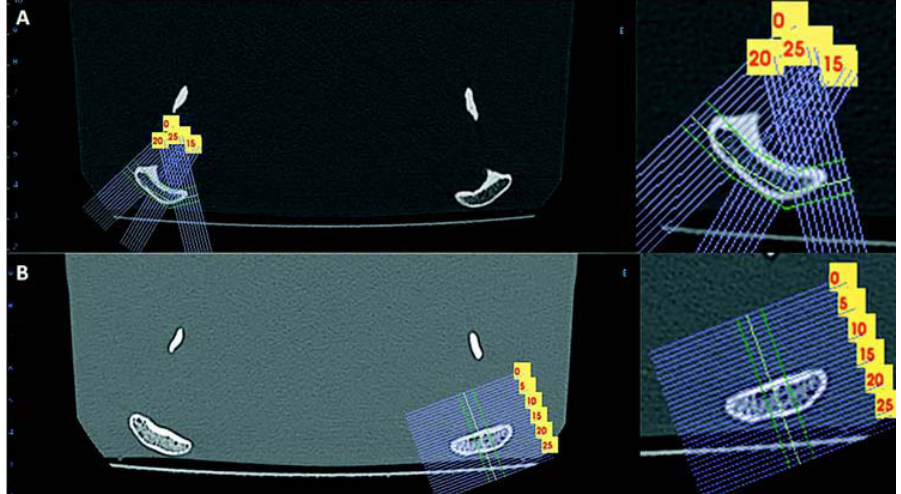
FIGURE 4- A- Parasagittal landmarks in the lateral-medial direction; B- Parasagittal landmarks in the anterior-posterior